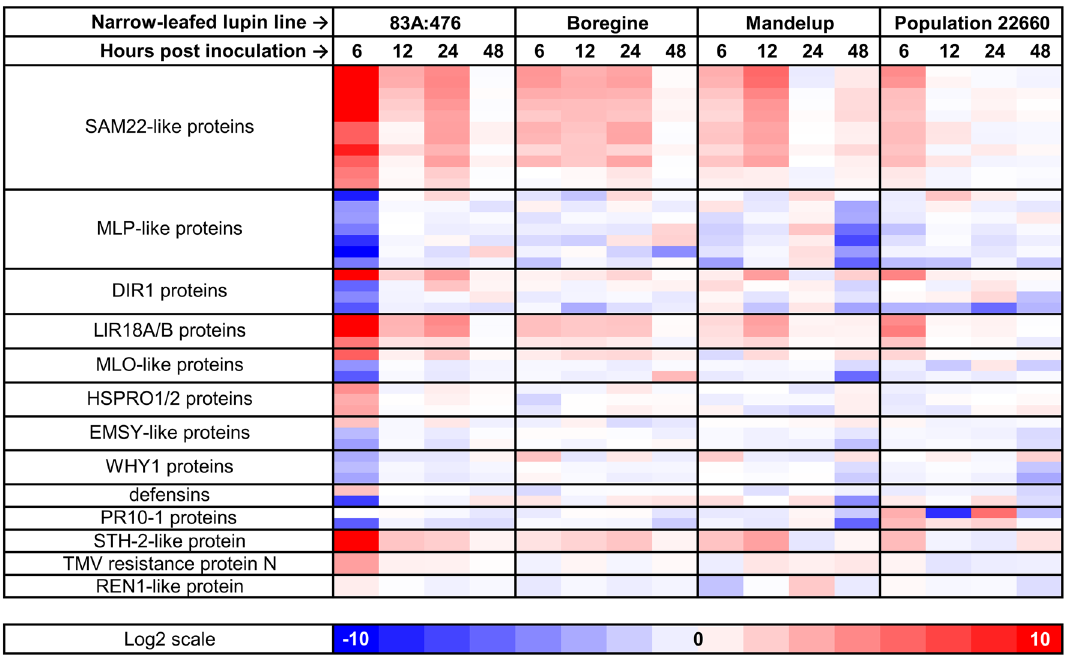
Figure 3. Expression patterns revealed for major components of biological process term “GO:0006952 defense response” and candidate genes for Lanr1 and AnMan alleles. Log2 scale represents the log2(fold-change) values between inoculated ( Colletotrichum lupini , strain Col-08, obtained in 1999 from the lupin field in Wierzenica, Poland) and control (mock inoculation) plants at the same time point. Analyzed narrow-leafed lupin lines were as follows: 83A:476 (resistant, carrying homozygous Lanr1 allele), Boregine (resistant, unknown genetic background), Mandelup (moderately resistant, carrying homozygous AnMan allele), and Population 22660